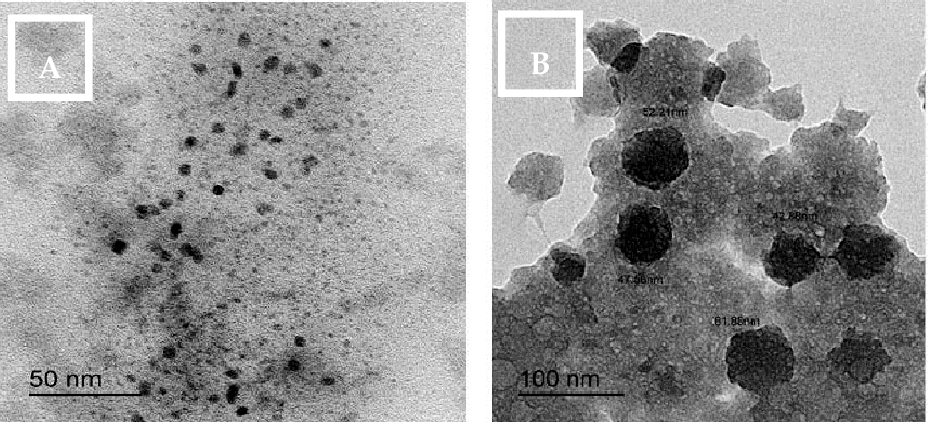
Figure 5. TEM image of [Se(folic)(chitosan)] complex. ( A ) Small black spots. ( B ) Black spots dispersed in gelatinous media.